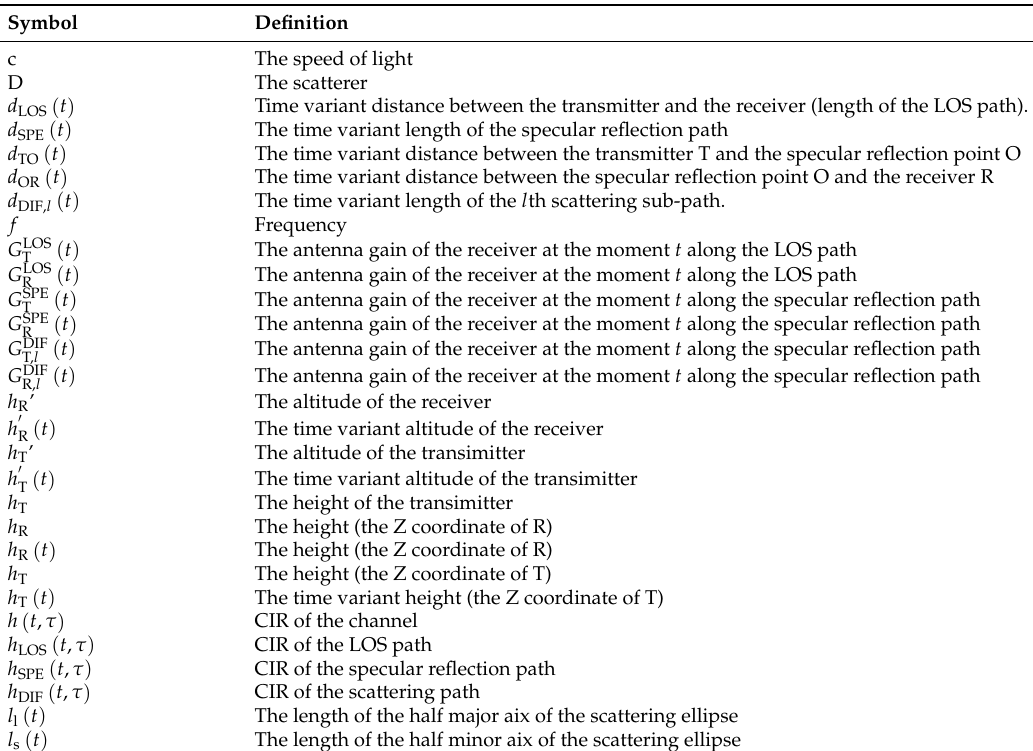
Figure 1. The geometrical structure of the system model. Table 1. Major parameters and symbols this